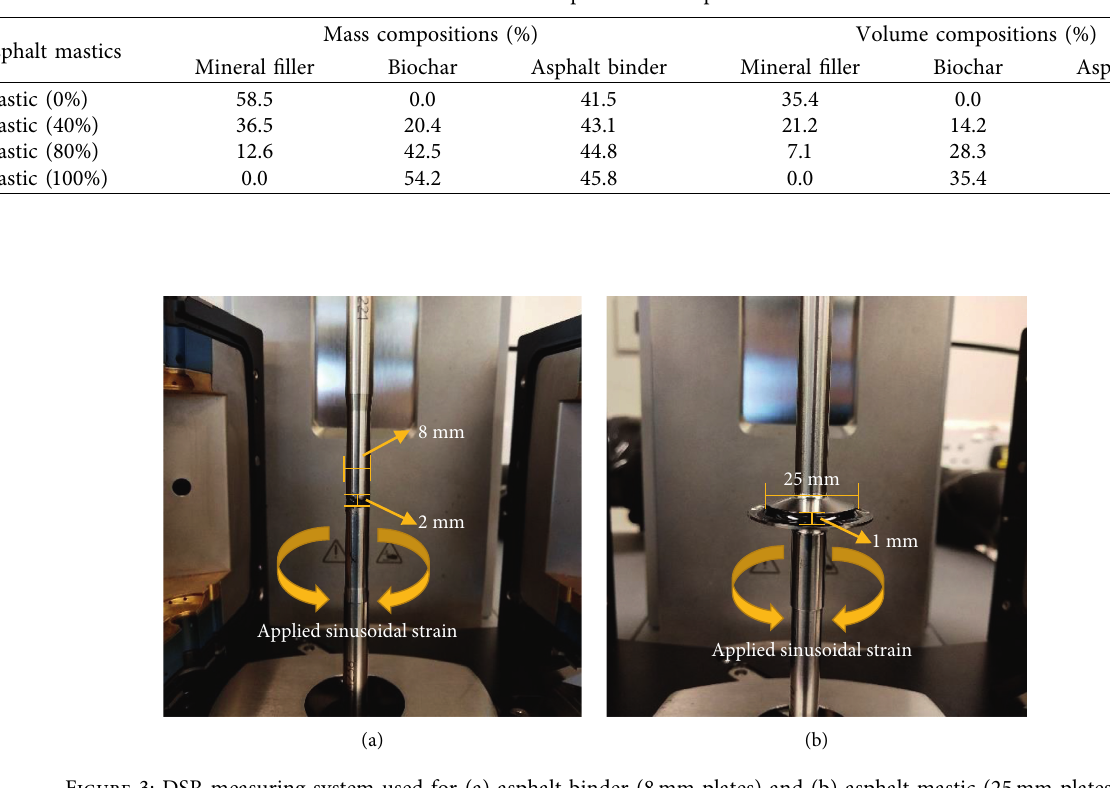
Table 2: Material compositions of asphalt mastics.